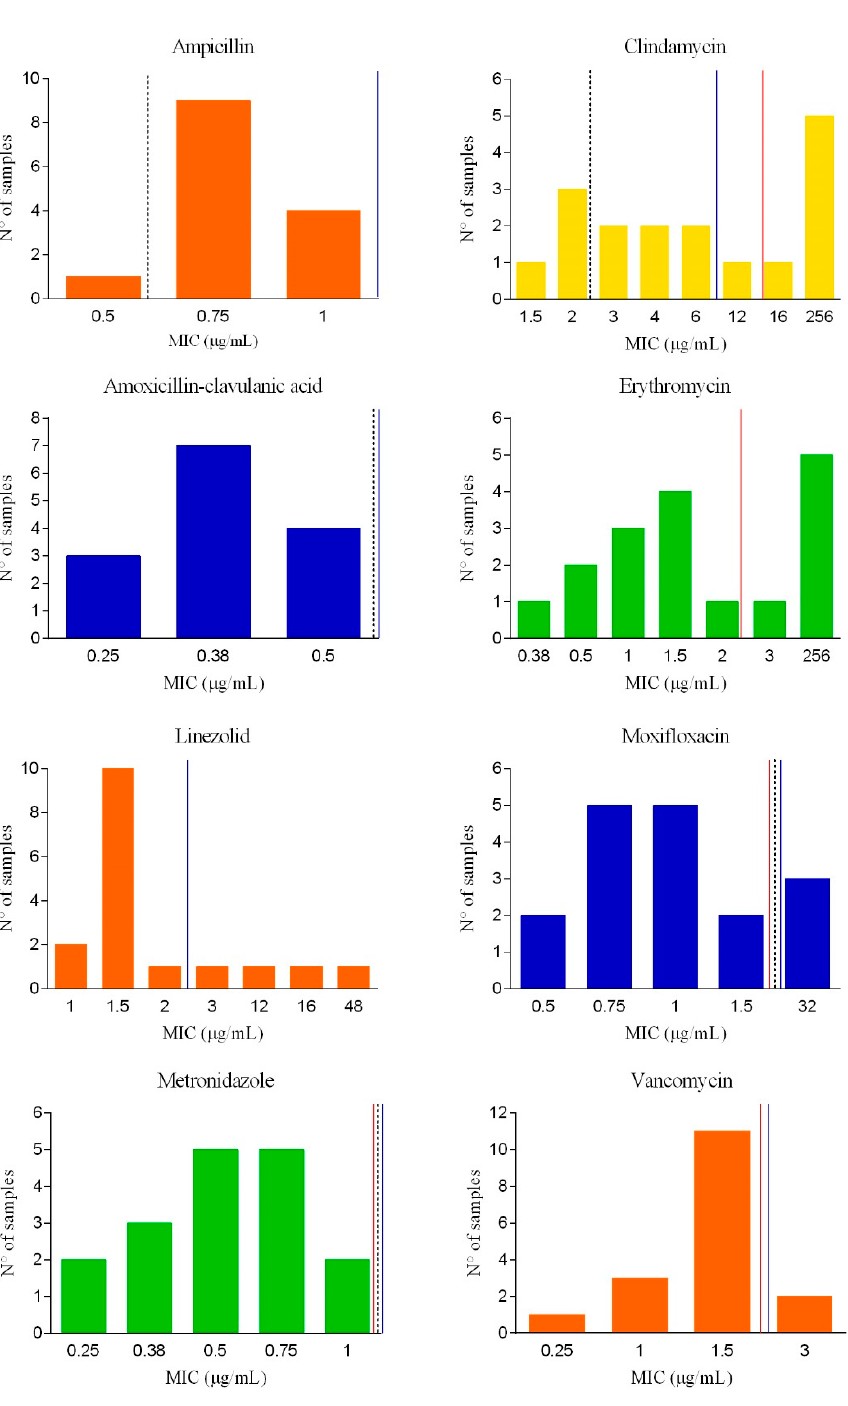
Figure 2. Distribution of minimal inhibitory concentration (MIC) values of C. difficile isolates from calves. Clinical breakpoints are represented as dotted lines (representing the limits of full susceptibility) and blue lines (resistance). Epidemiological cutoffs, when available, are represented with red lines.